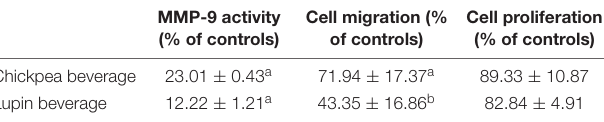
TABLE 5 | Effect of protein extracts from chickpea and lupin-based beverages on MMP-9 activity and on the migration and proliferation of HT-29 cells. MMP-9 activity Cell migration (% (% of controls) of controls)